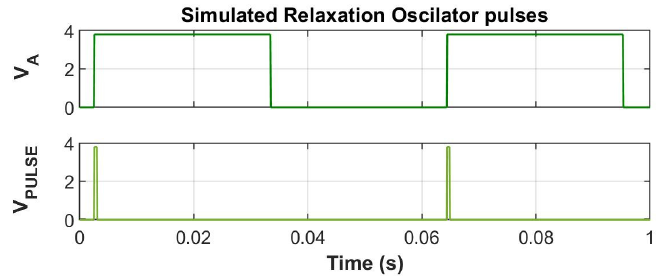
Figure 6. Simulated RO pulses with Multisim .